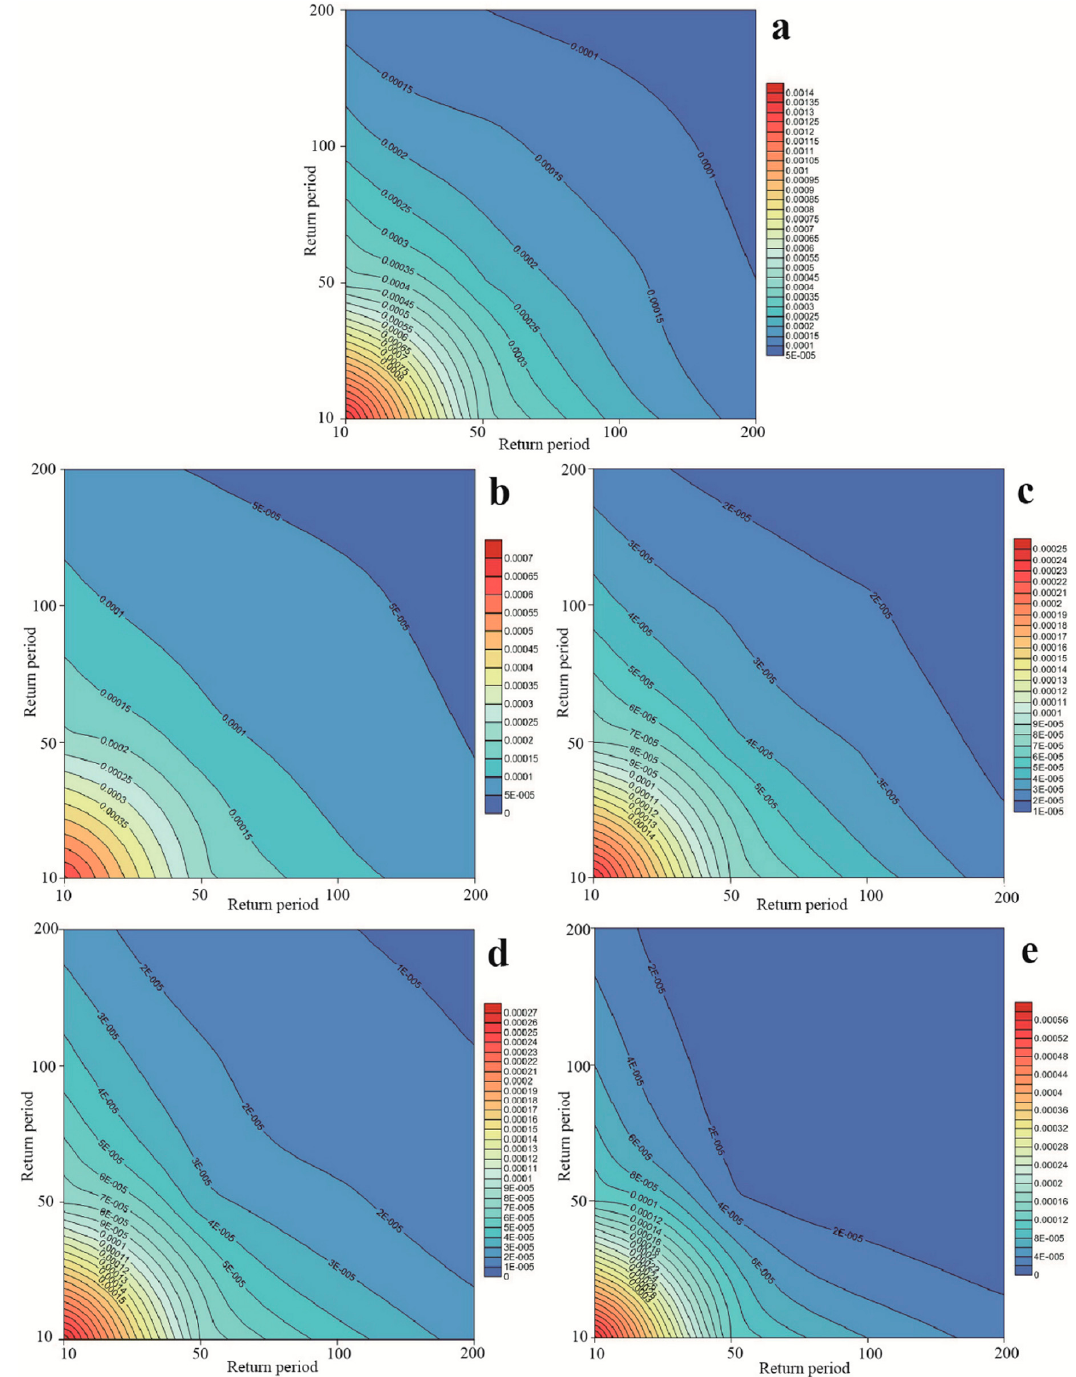
Figure 11. Encounter probability of flood magnitudes with different return periods in the flood season. ( a ) The reference period. ( b ) 2020–2049 period of scenario A2. ( c ) 2070–2099 period of